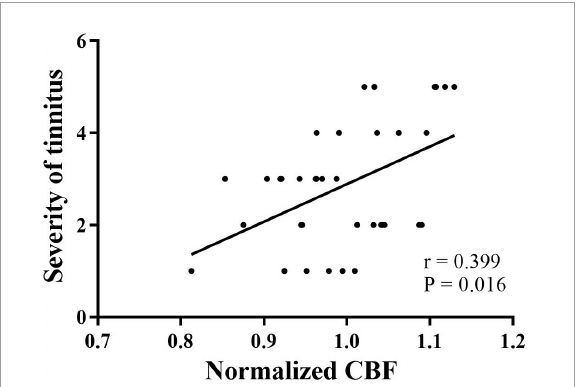
FIGURE4 Correlation between the normalized CBF of the left PAC and severity of tinnitus in patients with tinnitus. PAC, primary auditory cortex; CBF, cerebral blood flow. • Grades of tinnitus severity.